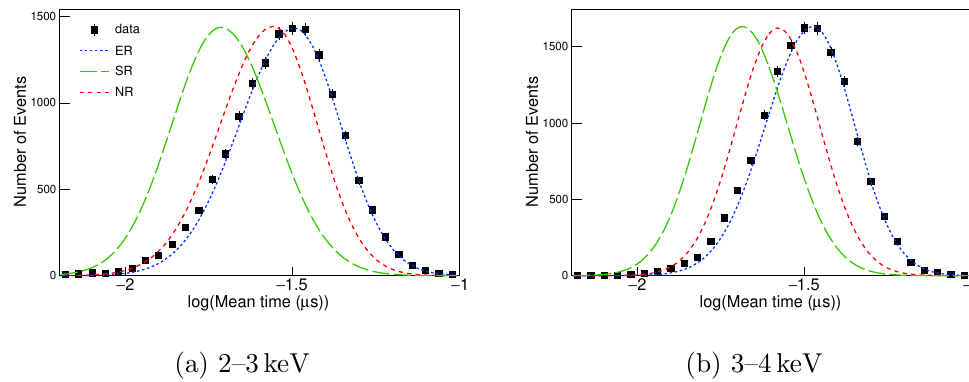
Figure 4 . The LMT distributions of data (point) in NaI2 are compared with PDFs of ER (dotted line), SR (long dashed line), and NR (dashed line) for events at 2{3 keV (a) and 3{4 keV (b).